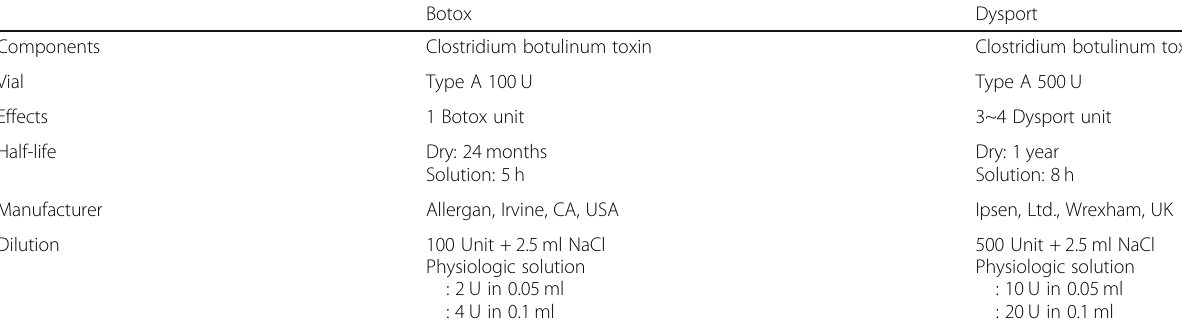
Table 1 Comparison of Botox and Dysport Botox Dysport Components Clostridium botulinum